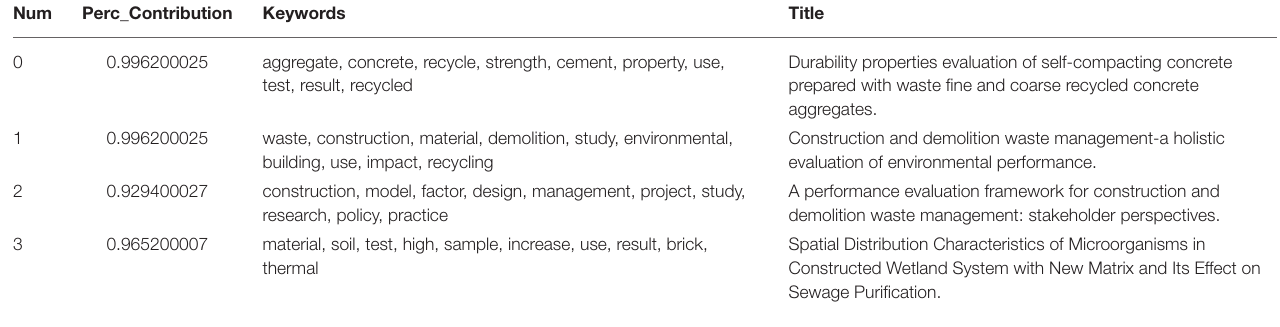
TABLE 2 | Document-topic probability distribution.